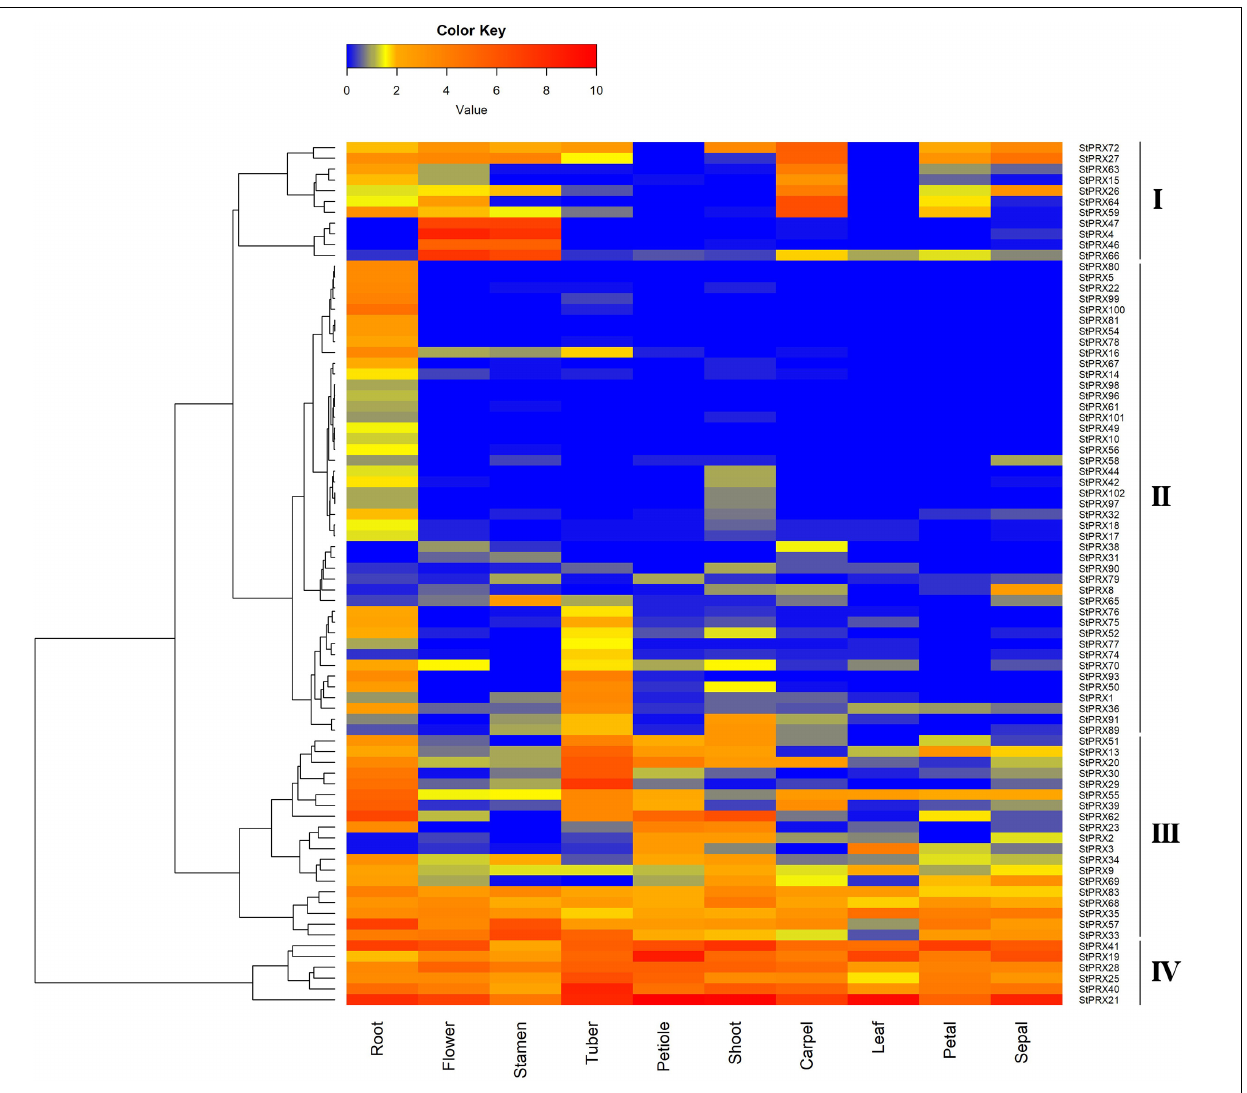
FIGURE 5 | Expression profiles of StPRX genes in different tissues. FPKM values for StPRX genes were transformed by log 2 (FPKM+1). The heatmap was generated using the R package of the heatmap